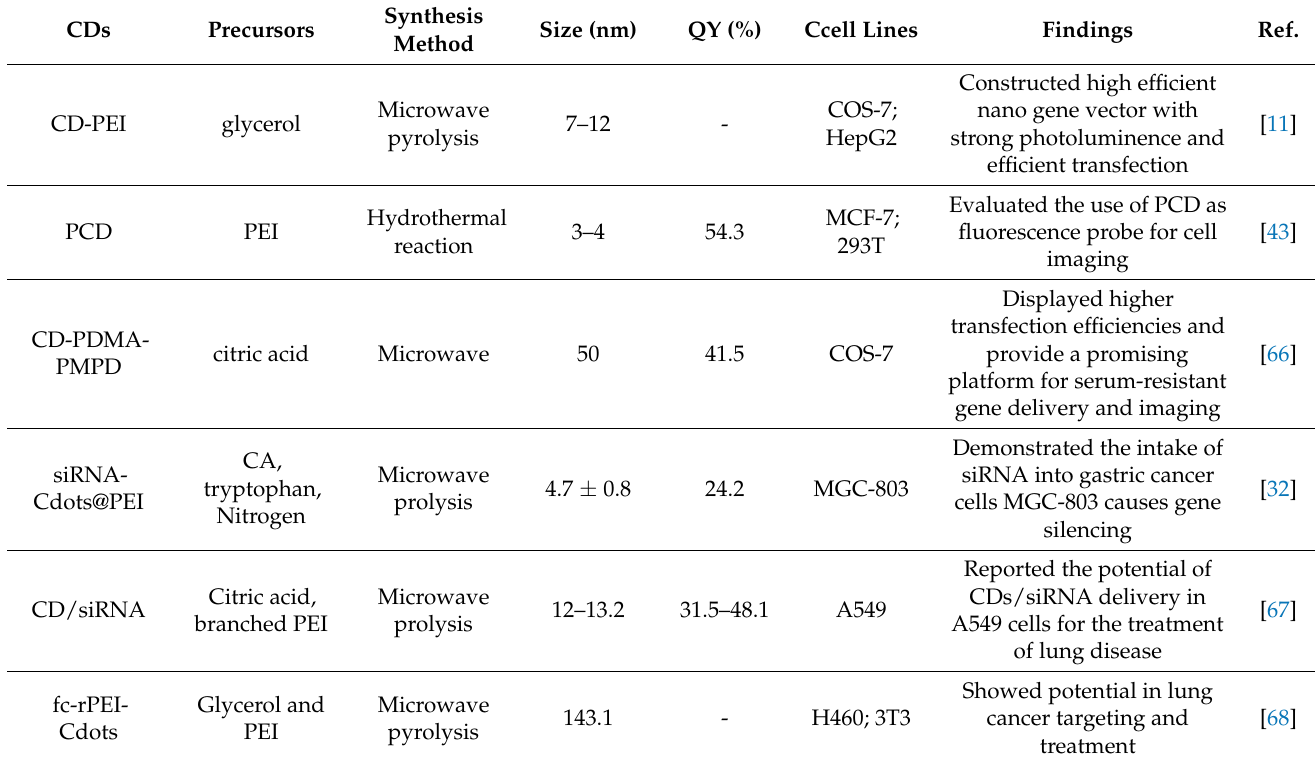
Table 2. Studies reported use of CDs in gene